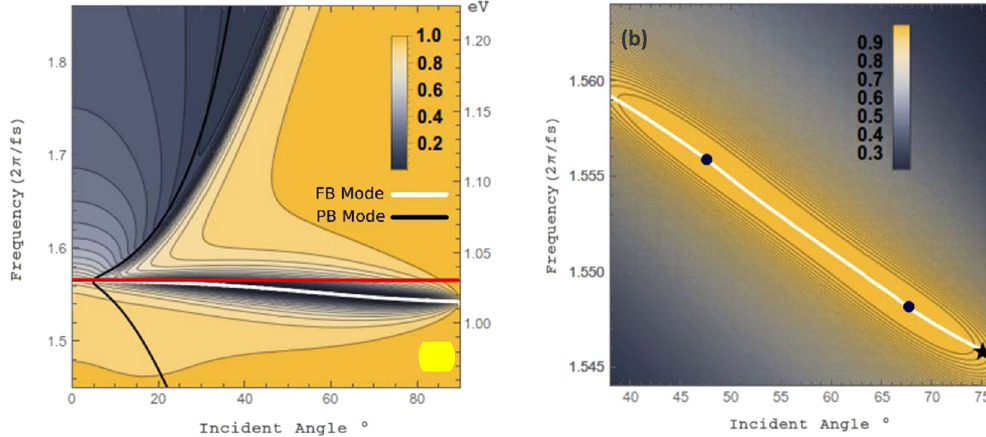
Figure 2. ( a ) Reflectivity profile as a function of incident angle (within SiO 2 ) and input frequency. The dispersion of a bulk plasmon polariton mode (FB, white solid line) overlapping dip in reflectivity is predicted to occur due to ENZ behavior circa a frequency of 1.565 rad/fs (gray horizontal line, red online). Expected plasmon resonances for ITO thin films appear in the upper left of the profile andresonance excitation of a pseudo-Brewster (PB, black curve) mode is also superimposed. ( b ) The absorbance for the structure with values reaching over 98% within the innermost contour. The FB mode covers frequencies corresponding to a wavelength range of roughly 1207–1219 nm. Points of perfect antireflection (PAR) points and a point of zero GVD (black star) are highlighted.